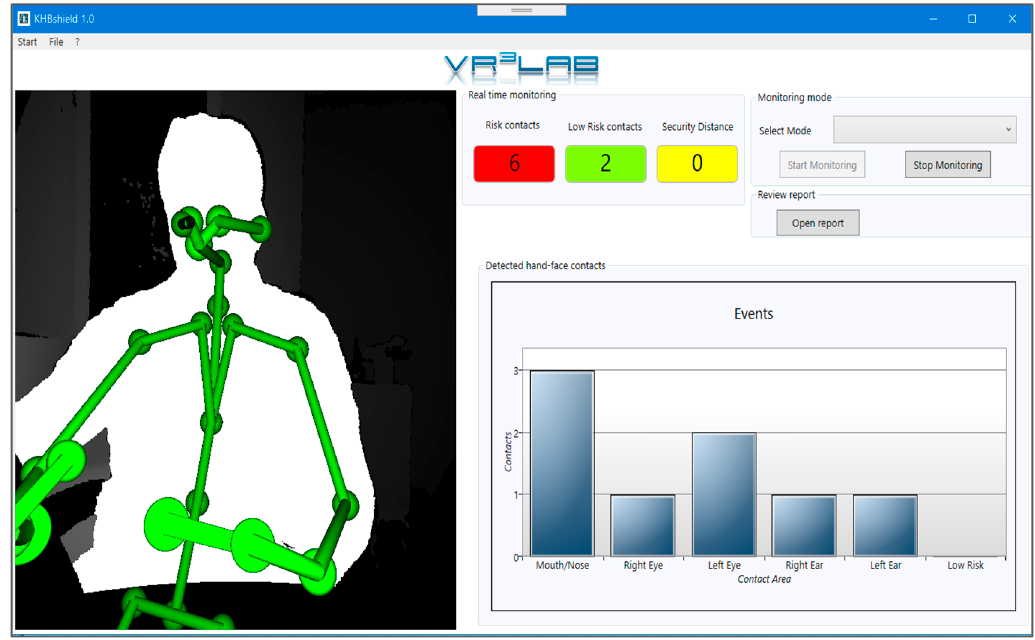
Figure A1. The HealthSHIELD tool’s main window for the real-time monitoring modality. In the display area, a worker at a seated workstation.